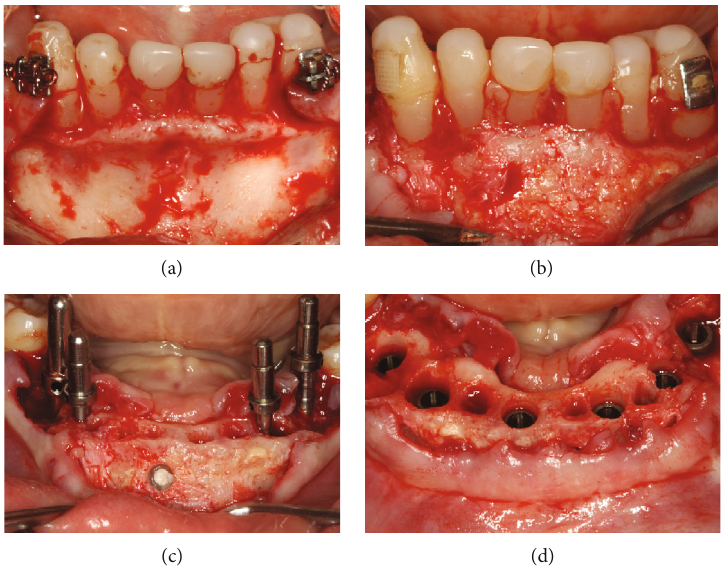
Figure 6: Intraoral view of the alveolar ridge before (a) and after (b) augmentation. Removal of bone fragment using a 2.0mm trephine for histological analysis of the grafted area (c). Six implants in place with initial torque of 35 N/cm